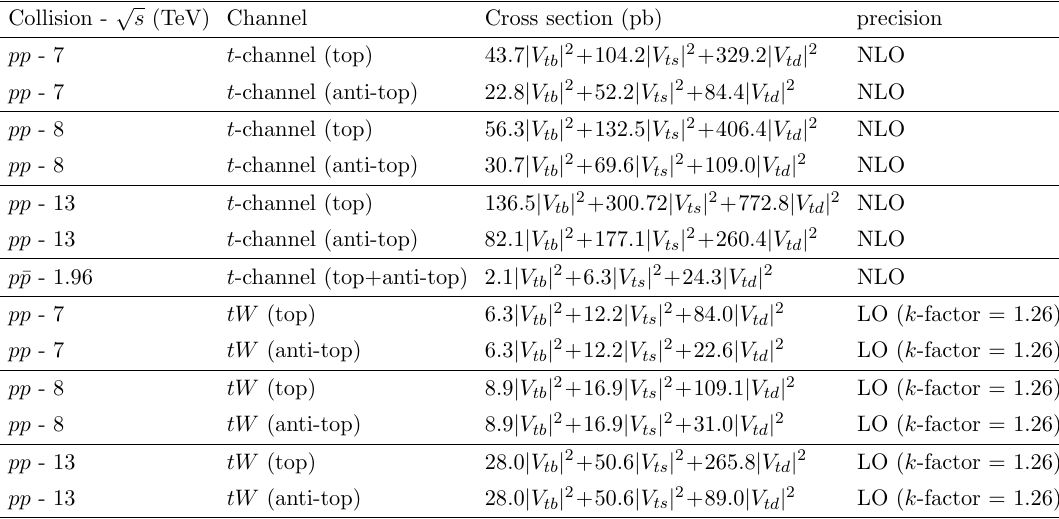
Table 2 . Single top quark production cross section (in pb) via t -channel and tW -channel at center of mass energies of 7, 8 and 13 TeV of the pp collision data and 1.96 TeV of the p (cid:22) p collision data as a function of j V td j , j V ts j and j V tb j . No phase space cut is implemented on the (cid:12)nal-state particles. NNPDF3.1 is used to evaluate the parton densities, while the renormalization scale and factorization scale are set to the top quark mass ( m t = 172.5